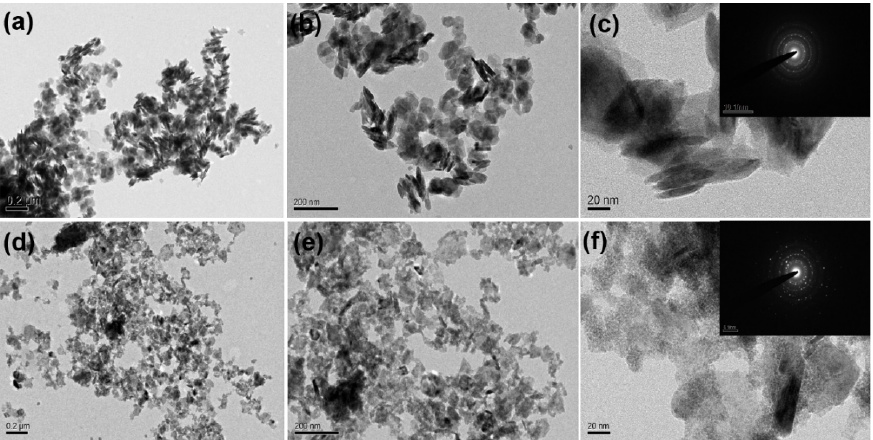
Figure 2. ( a – c ) Transmission electron microscopy (TEM) images of SnS 2 and inset in Figure 2c shows selected area electron diffraction (SAED) pattern of SnS 2 nanoflakes; ( d – f ) TEM images of a typical Sn 0.97 Zn 0.03 S 2 nanoflakes with SAED pattern in inset of Figure 2f, revealing polycrystalline structure.